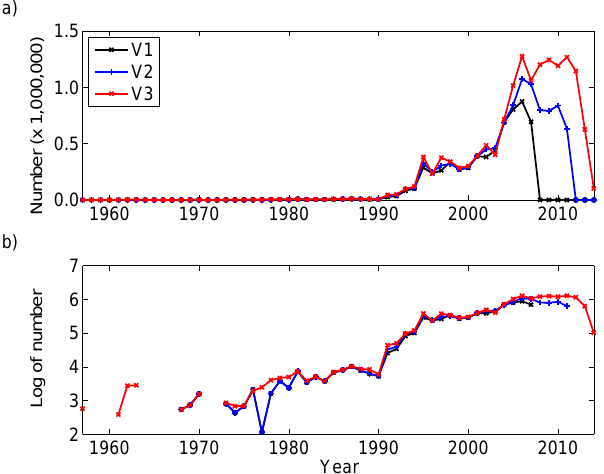
Figure 2. (a) Number of surface water f CO 2 values per year and (b) the base 10 logarithm of this number per year for 1957 to 2014 in SOCAT versions 1, 2 and 3 (after Bakker et al.,